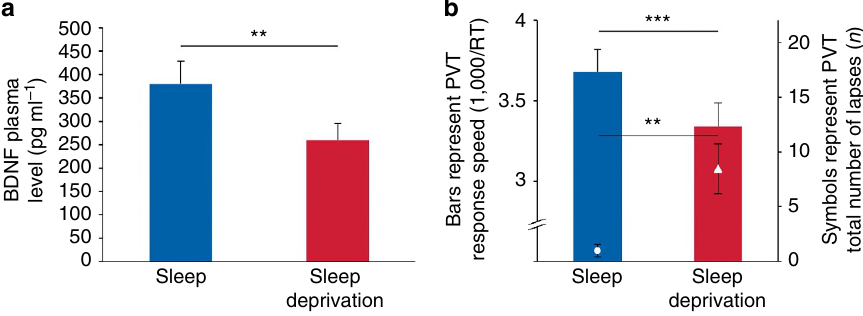
Figure 4 | Potential modulators of synaptic plasticity. ( a ) Brain-derived neurotrophic factor (BDNF) plasma level was significantly lower after sleep deprivation compared with sleep. ( b ) After sleep deprivation, the participants were less vigilant, as indicated by a significant reduction in response speed (1,000ms per reaction time) and a significant increase in the total number of lapses (reaction time Z 500ms) in the Psychomotor Vigilance Task